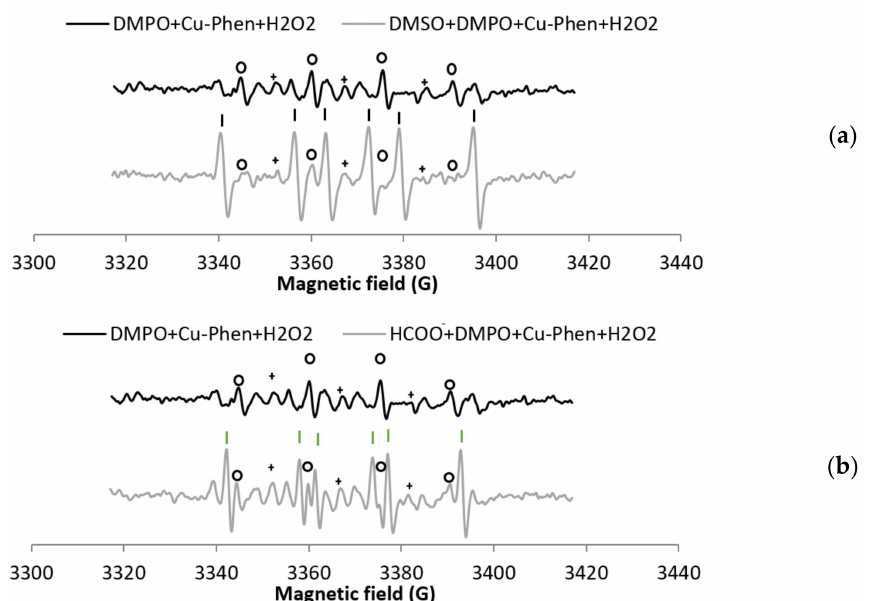
Figure 9. X-band EPR spectra of ( a ) NaOH + DMPO + Cu–Phen + H 2 O 2 and NaOH + DMSO + DMPO + Cu–Phen + H 2 O 2 and ( b ) NaOH + DMPO + Cu–Phen + H 2 O 2 and NaOH + HCOO − + DMPO + Cu–Phen + H 2 O 2 -. The simulations revealed the presence of several radical species. Without scavenger (exp 20): DMPO–OH, a N = 15.439 G, a H = 15.049 G; DMPO–R, a N = 15.79 G, a H = 23.488 G; “triplet radical”, a N = 14.646 G. With DMSO (exp 21): DMPO–OH, a N = 13.926 G, a H = 14.072 G; DMPO–CH 3 , a N = 15.937 G, a H = 22.658 G; “triplet radical”, a N = 14.788. With HCOO − (exp 22): DMPO–OH, a N = 15.342 G, a H = 15.537 G; DMPO–R, a N = 15.742 G, a H = 24.123 G (minor); “triplet radical”, a N = 14.691 G; DMPO–COO − , a N = 15.805 G, a H = 19.049 G - Assignments: o = DMPO–OH, | = DMPO–CH 3 , + = “triplet radical”, | = DMPO–COO − .